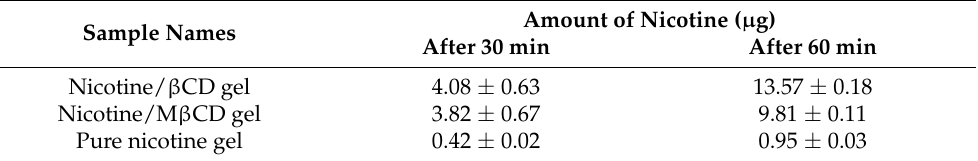
Table 3. Amount of permeated nicotine from